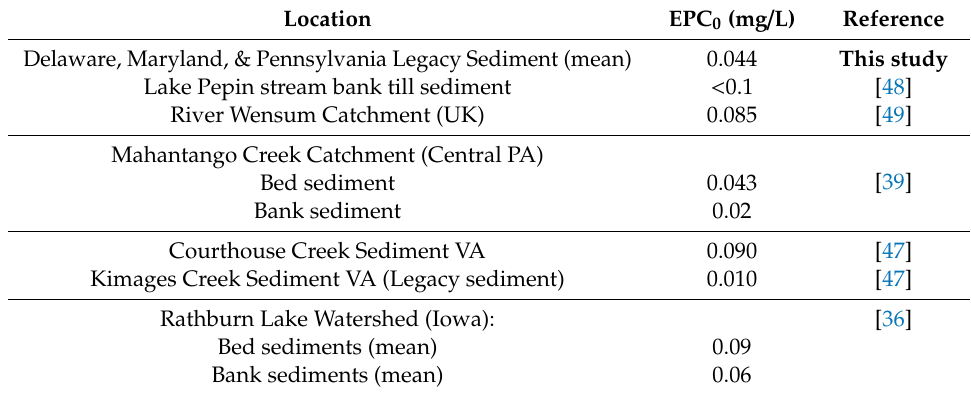
Table 4. Comparison of EPC 0 values from various sites and sediments types reported in the